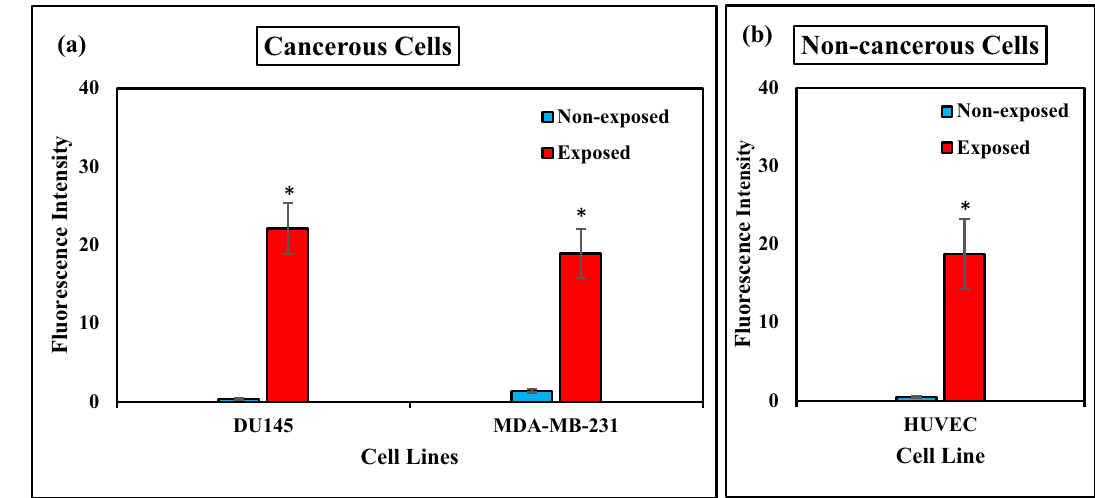
Figure 11. ELF-EMF increases intracellular ROS levels. We used Flow cytometry to determine the effect of ELF-EMF on ROS production by DU145, K562, HUVEC cell lines (0.01 Hz, 100 mT, 120 h), and MDA-MB-231 cell line (1 Hz, 100 mT, 120 h). Bar plot shows the quantitative analysis of the fluorescence intensity in the non- exposed and exposed ( a ) cancerous, ( b ) non-cancerous cells of ELF-EMF stained with DCFH-DA. Bars indicate means ± SEM obtained from three or more independent experiments. Statistical significance between non- exposed and exposed groups was evaluated by the t-test. ( P -value < 0.05) was considered to indicate statistical significance.